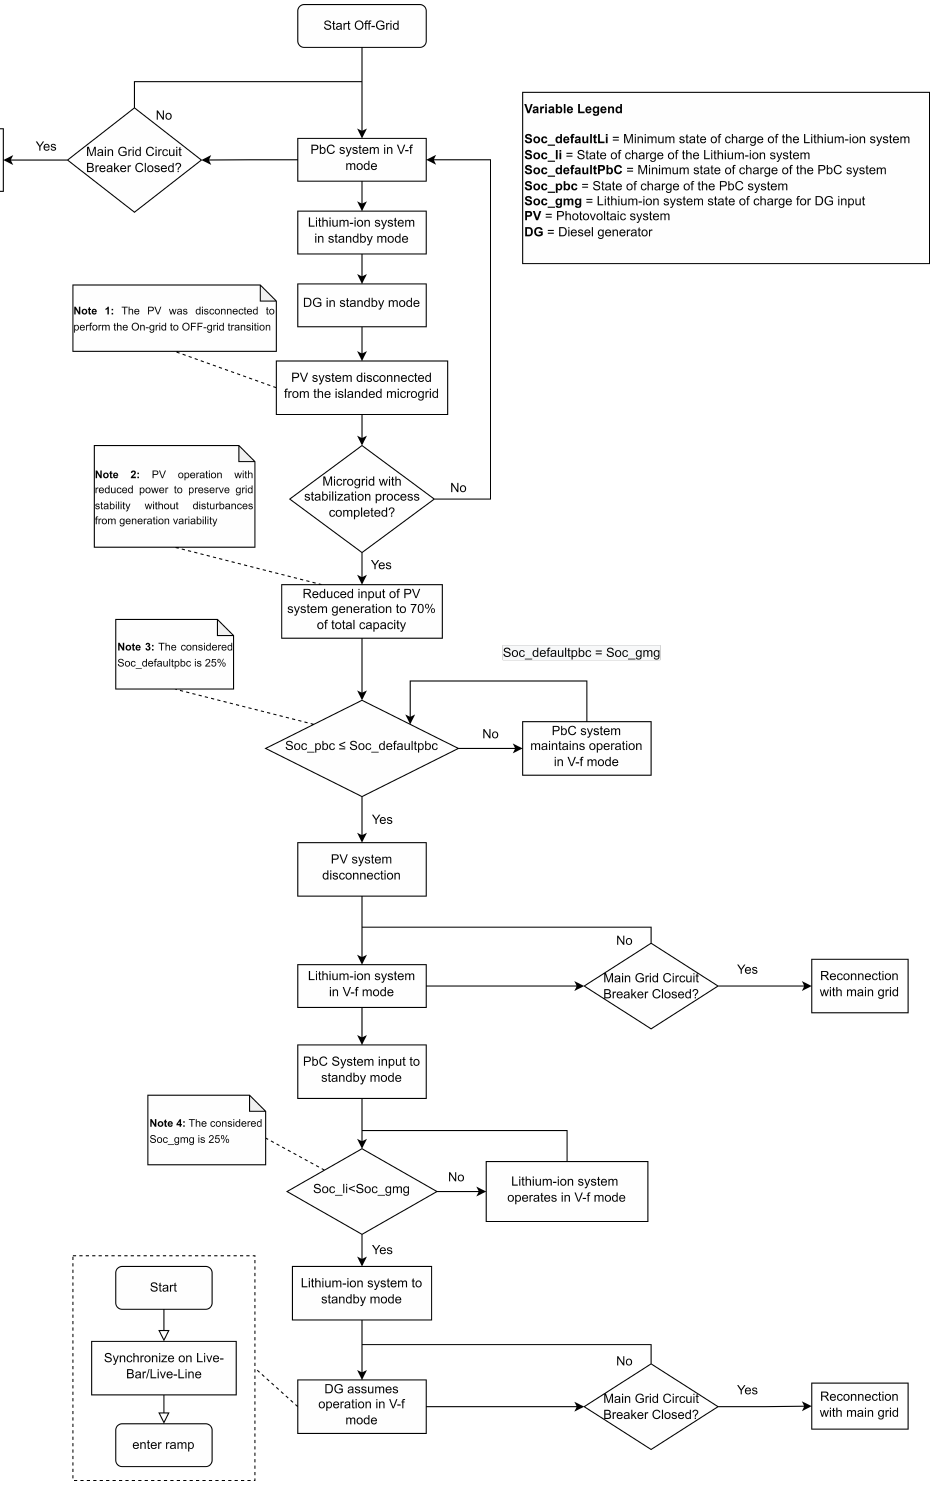
Figure 5. Main Scenario Offgrid (island